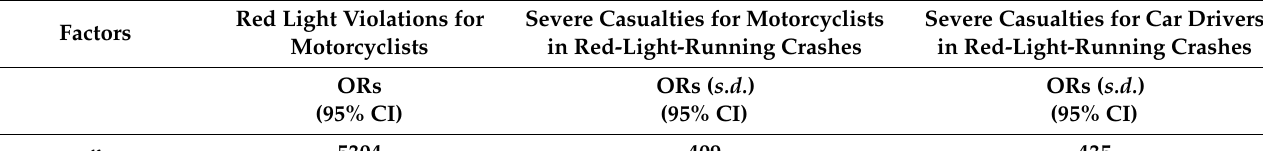
Table 2. Factors influencing motorcyclists running red lights and resulting severe